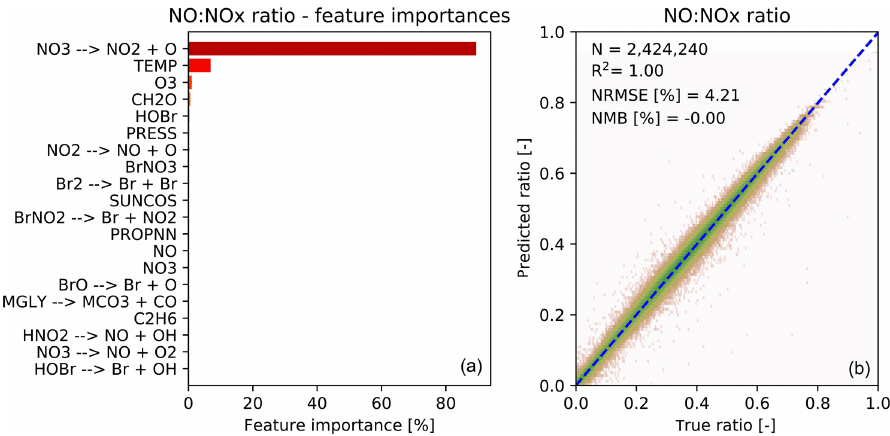
Figure 5. Characteristics of random forest trained to predict the NO / NO x ratio after chemistry. (a) 20 most important features for the NO / NO x random forest, as averaged over all 30 decision trees. The black bars indicate the standard deviation of the feature importance; (b) Comparison of predicted NO / NO x ratios ( y axis) vs. true NO / NO x ratios ( x axis) for the validation data (not used for training). Number of validation points ( N ), correlation coefficient ( R 2 ), normalized root mean square error (NRMSE) and normalized mean bias (NMB) are given in the